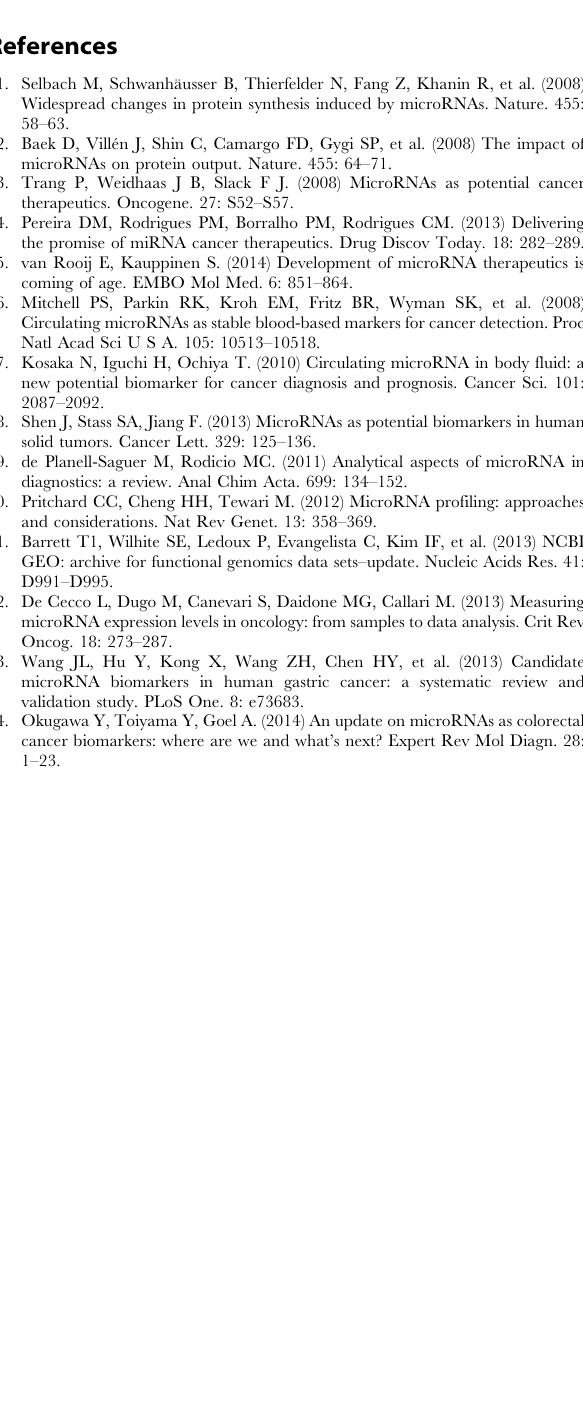
Figure S1 Comparison of miRNA expression and miRNA scores between the two patient groups